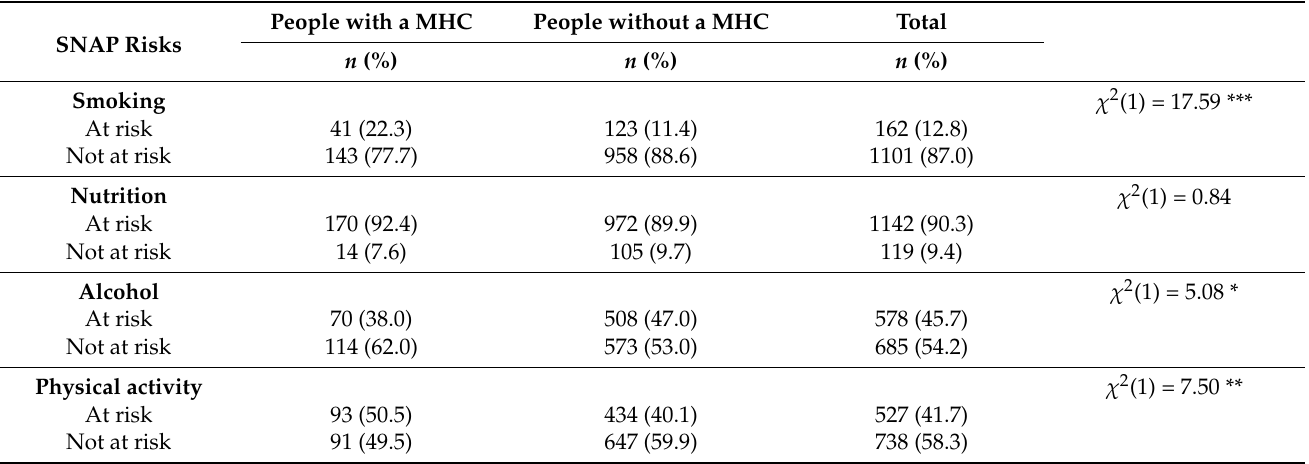
Table 3. Prevalence of SNAP Risks among People with and without a Mental Health Condition.